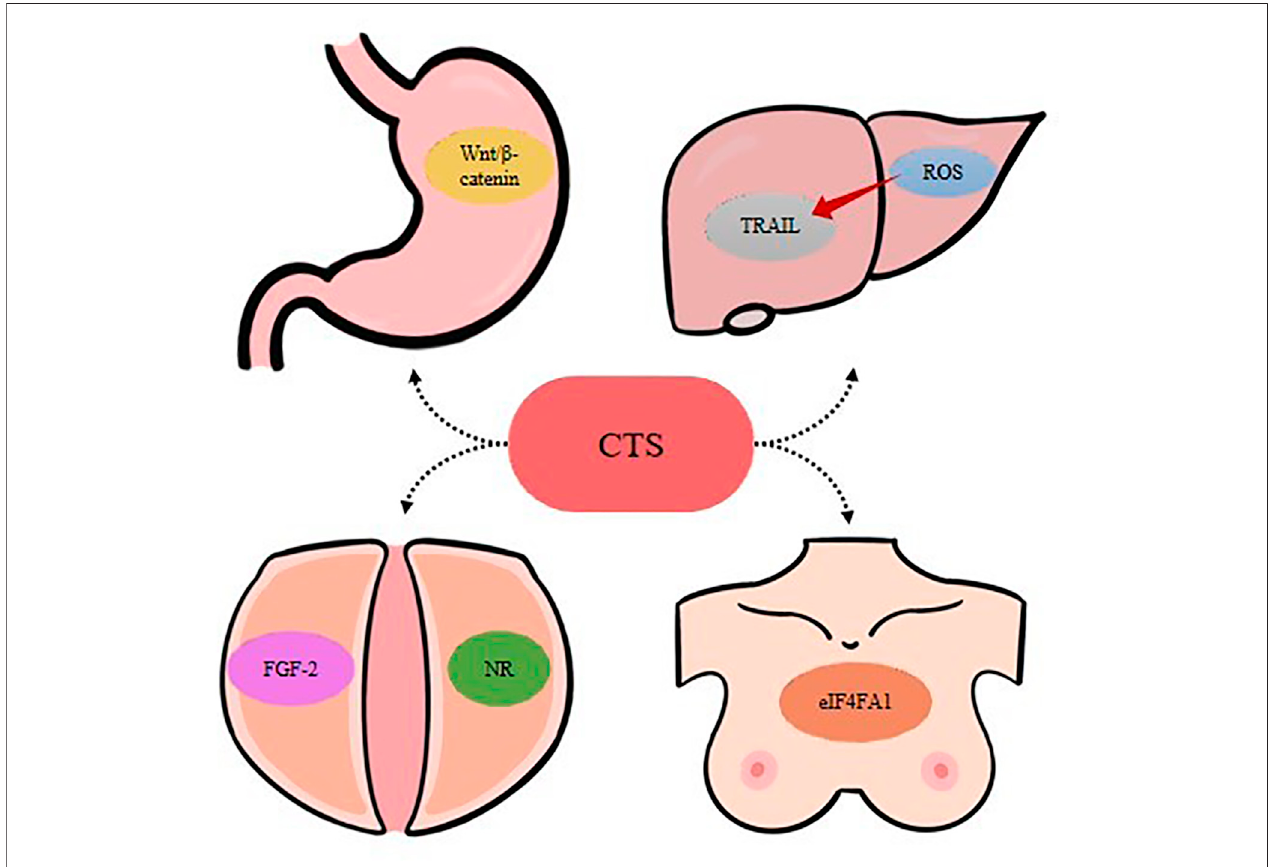
FIGURE 5 | Schematic diagram of the antitumor mechanisms of